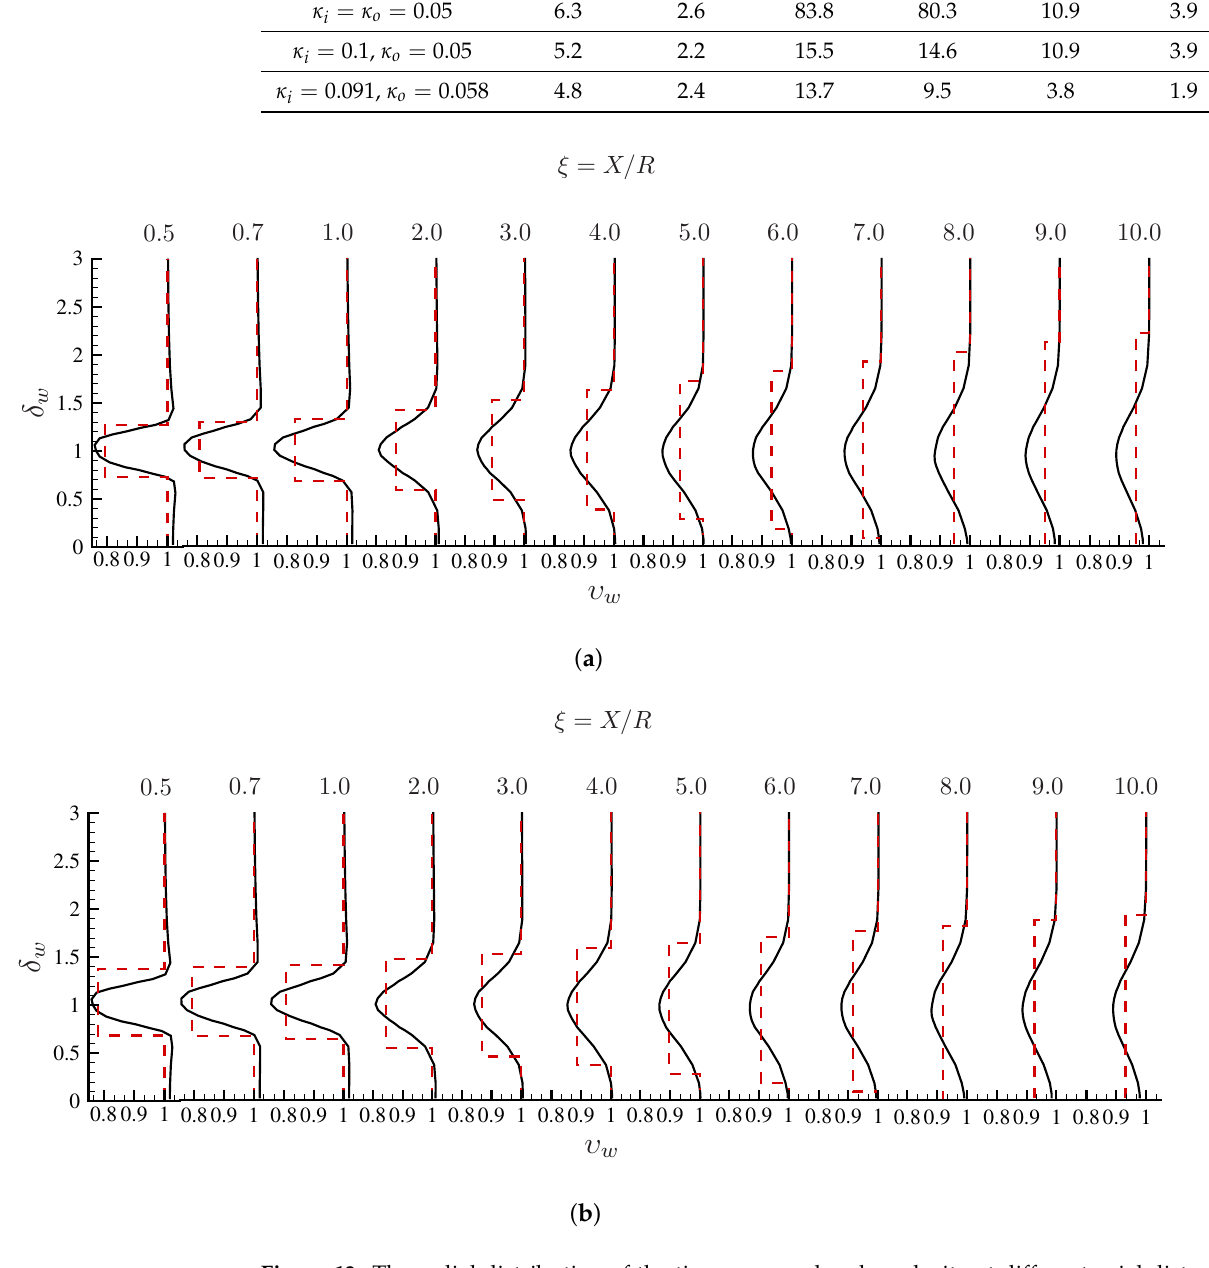
Figure 13. The radial distribution of the time-averaged wake velocity at different axial distances from the rotation plane; [ ] CFD results, [ ] analytical results: ( a ) κ i = κ o = 0.1, and ( b ) κ i = 0.091, κ o =